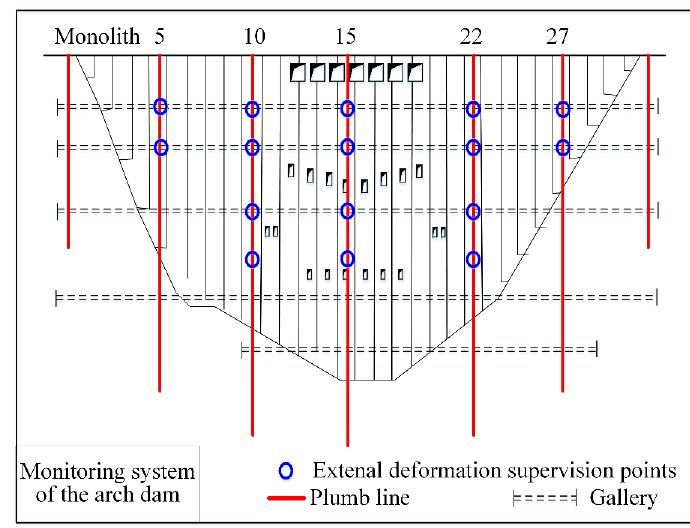
Figure 8. Layout of the plumb line system and external deformation supervision system.